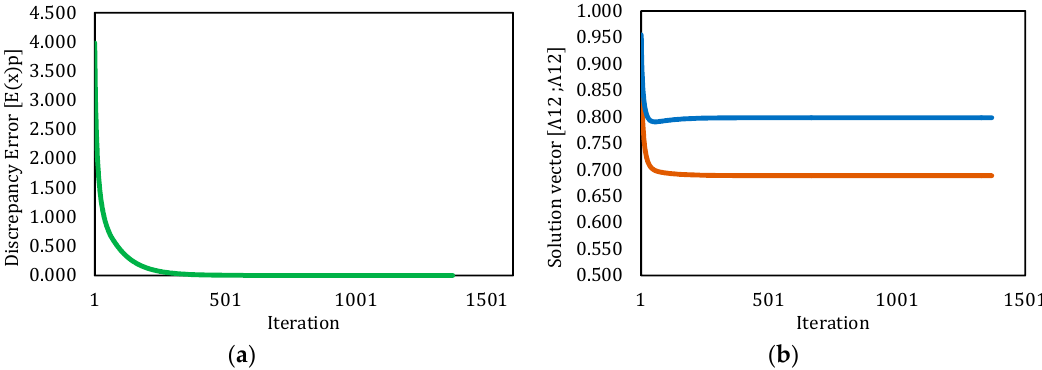
Figure 9. Behavior of discrepancy error and solution vector for Levenberg–Marquardt method-simulation 2. ( a ) Behavior of discrepancy error respect to iterations. ( b ) Behavior of values for solution vector respect to iterations.